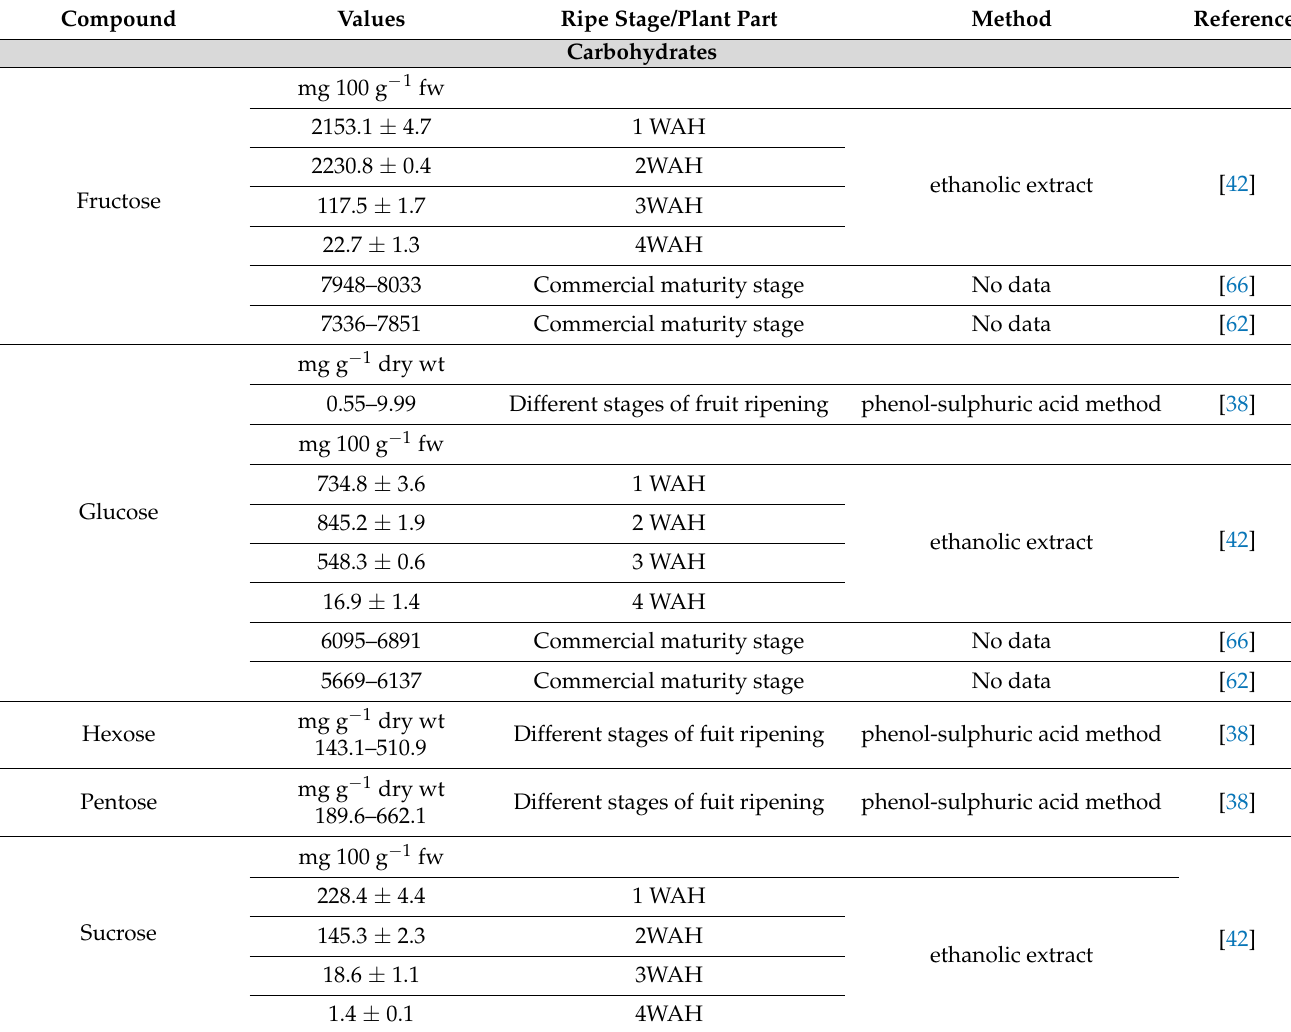
Table 8. Other chemical compounds in medlar